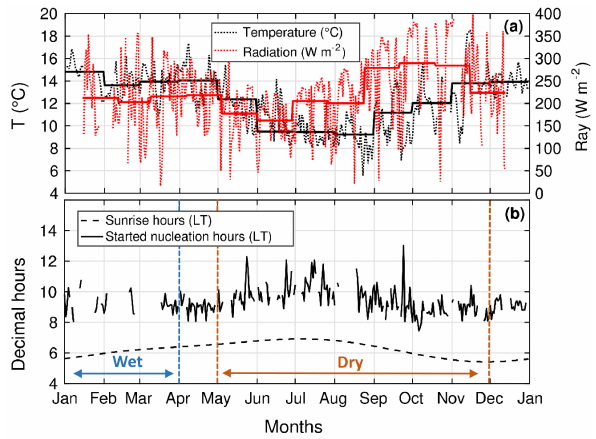
Table 2. R correlation coefficients giving the relationships between NPF parameters (occurrence, GR, and J s) and influencing